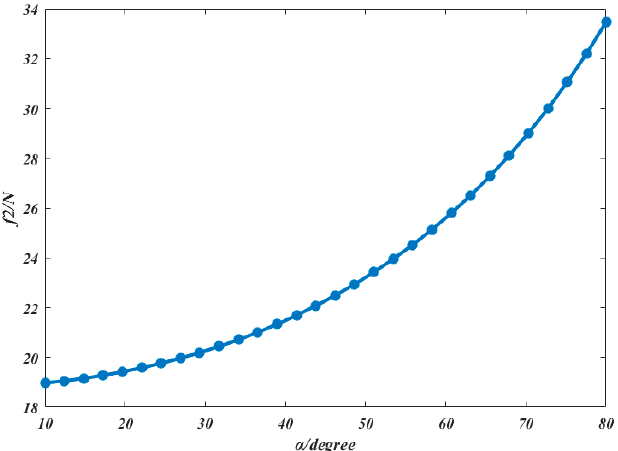
Figure 15. Grasping force under the coupled grasping mode.